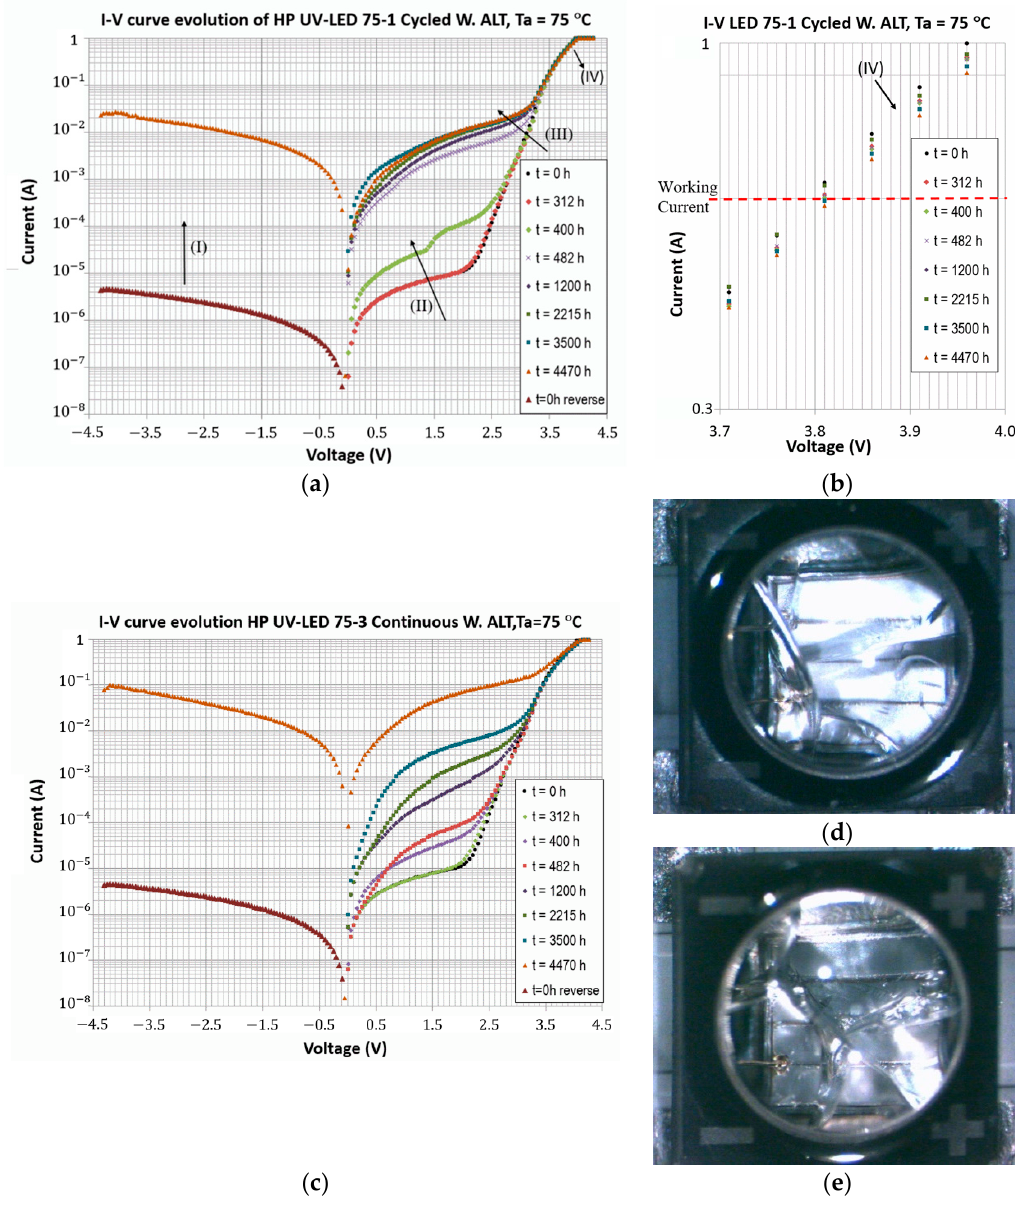
Figure 6. Test results measured outside the climatic chamber at T a = 25 °C. ( a ) I–V curve evolution in ALT of UV LED 75-1 of Figure 3, tested at T a = 75 °C with cycled working; ( b ) detailed I–V curve evolution of LED 75-1 with the nominal working condition 0.6 A; ( c ) I–V curve evolution in ALT of UV LED 75-3 of Figure 3, tested at T a = 75 °C with continuous working; ( d ) photograph of cycled working LED 75-1 encapsulation at the end of ALT; ( e ) photograph of continuous working LED 75-3 encapsulation at the end of ALT.